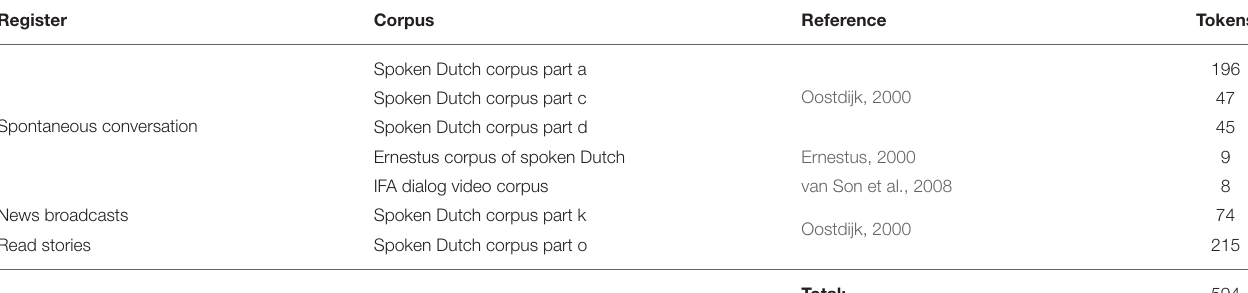
TABLE 4 | Overview of the corpora used in the durational study, including the number of -s plural tokens that were selected.